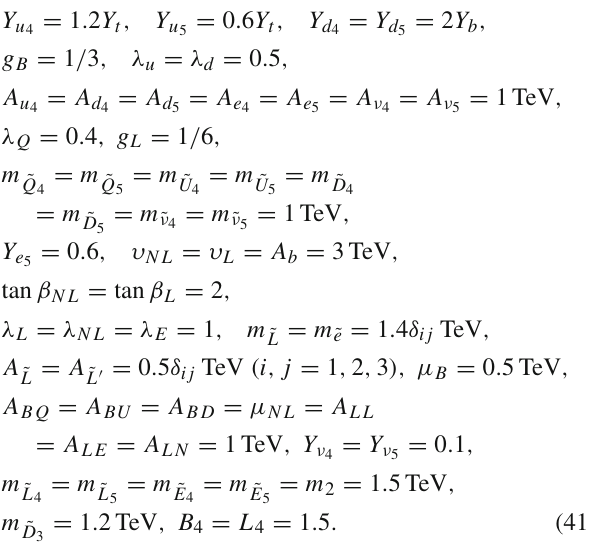
( m 0 ) varying with A H